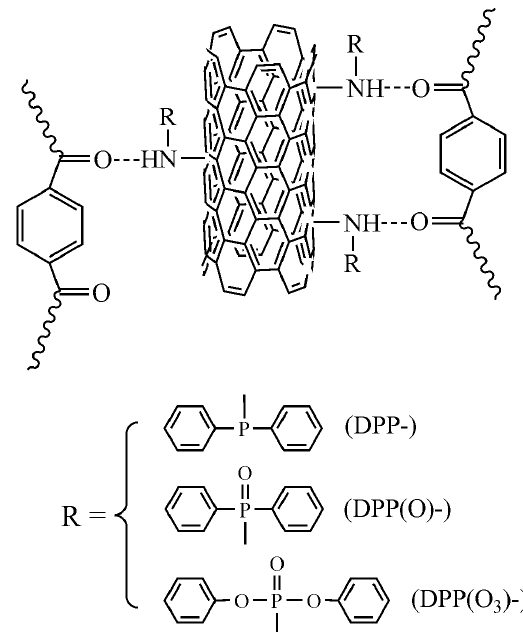
Figure 4. Schematic representation of the hydrogen-bond interaction between functionalized CNTs and PBT macromolecular chains.